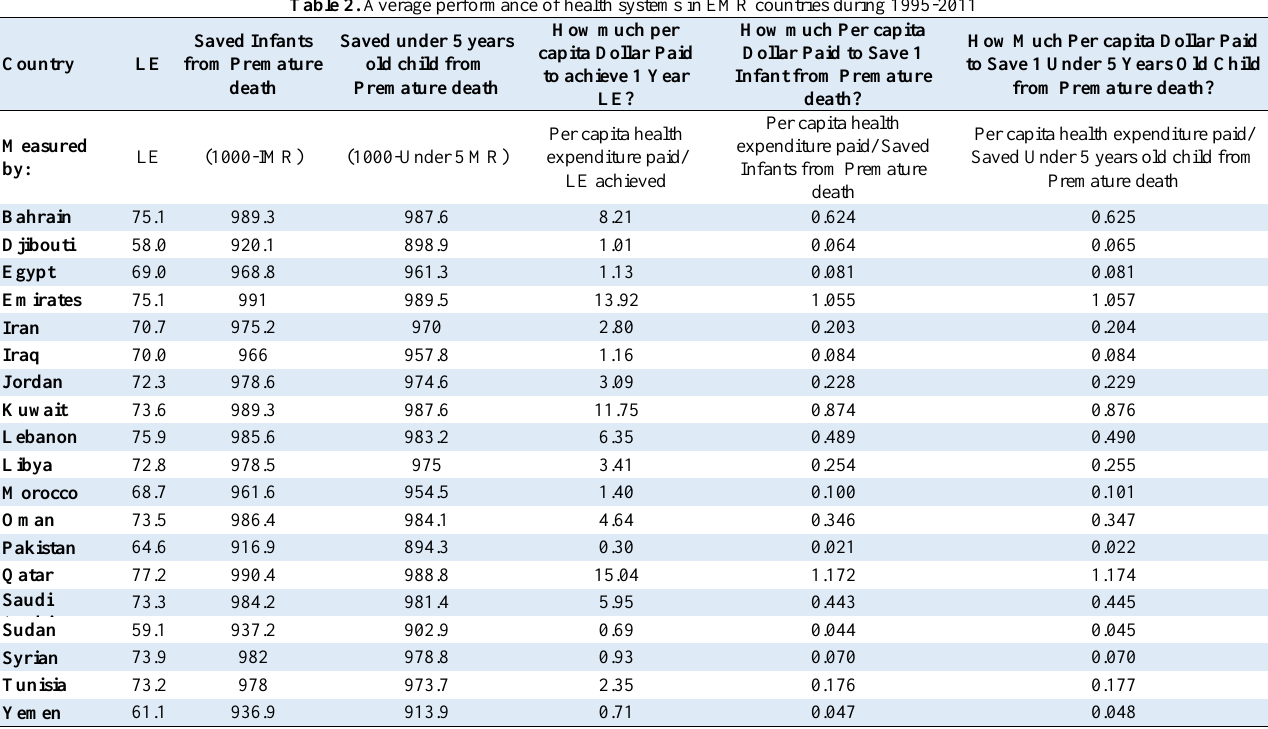
Table 2. Average performance of health systems in EMR countries during 1995-2011